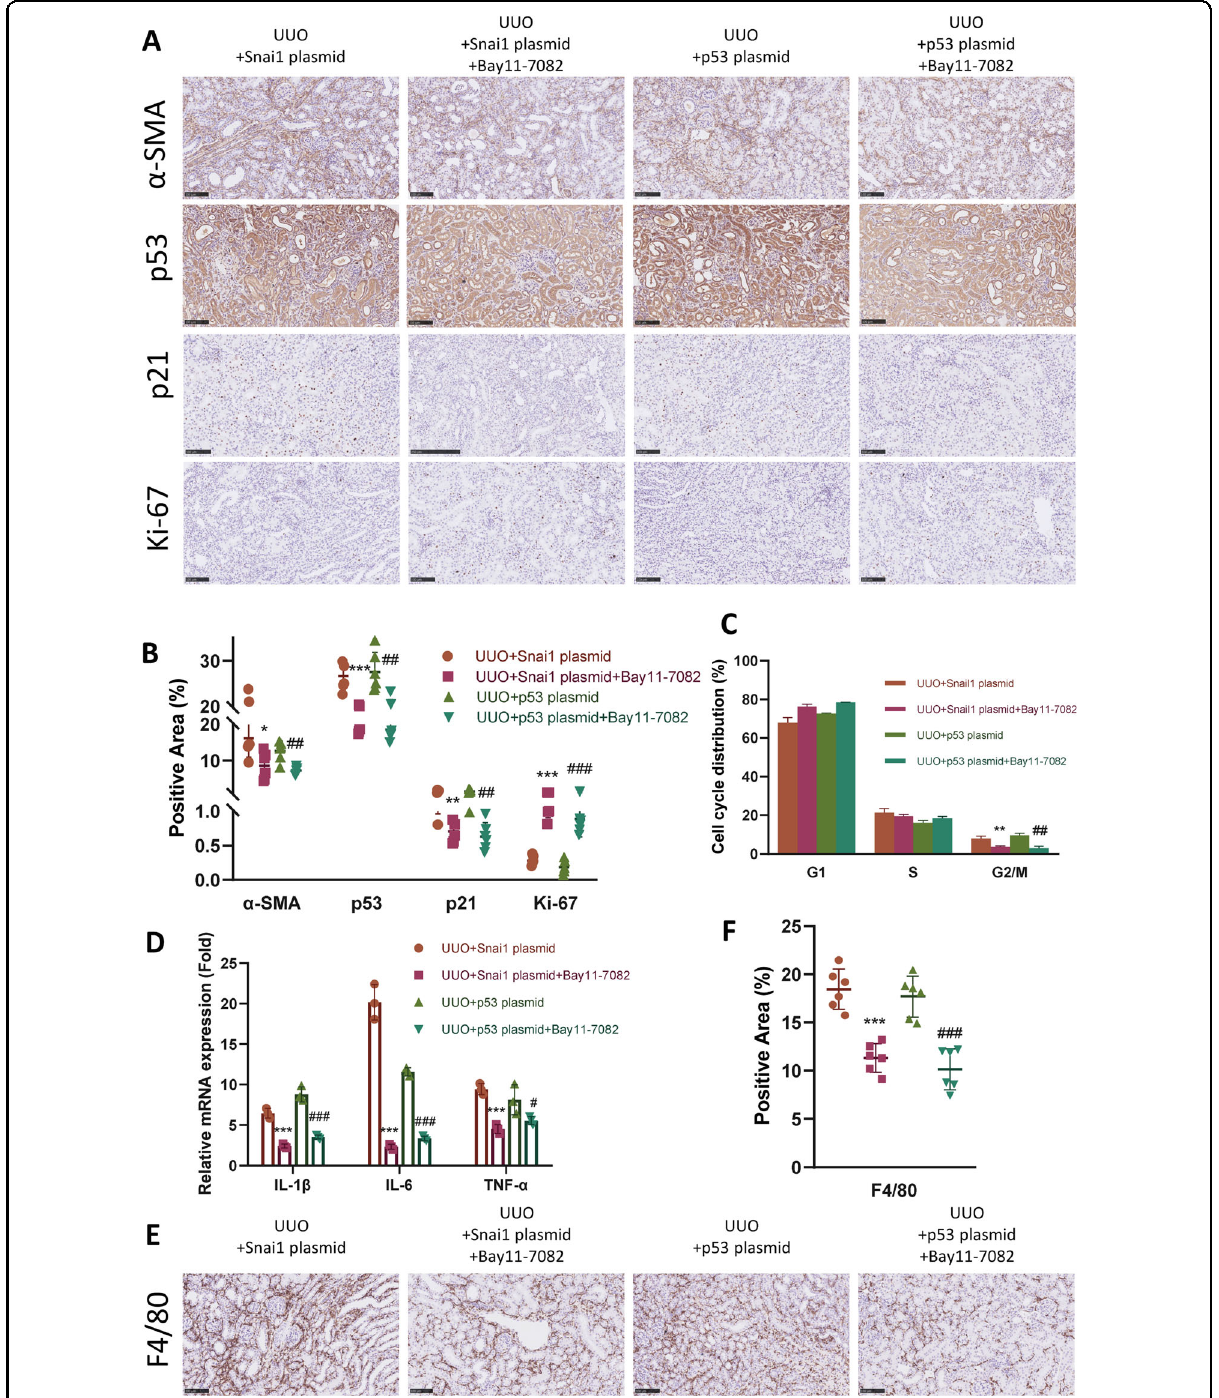
Fig. 8 Snai1-induced EMT orchestrates p53 – p21 axis via NF- κ B pathway. UUO mice were injected with Bay11-7082, the NF- κ B inhibitor after the administration of either Snai1 or p53 plasmid. A Immunohistochemistry staining of α -SMA, p53, p21, and Ki-67 in different groups and B their quanti fi cations. Scale bar = 100 μ m for α -SMA and scale bar = 50 μ m for p53, p21, and Ki-67. C Cell cycle distribution of TECs isolated from obstructed kidneys in different groups. D Relative mRNA expression of IL-1 β , IL-6, and TNF- α in kidneys from different groups. E Immunohistochemistry staining of F4/80 in different groups and F their quanti fi cations. Scale bar = 100 μ m. * P < 0.05; ** P < 0.01; *** P < 0.001 compared with UUO + Snai1 plasmid group. # P < 0.05; ## P < 0.01; ### P < 0.001 compared with UUO + p53 plasmid